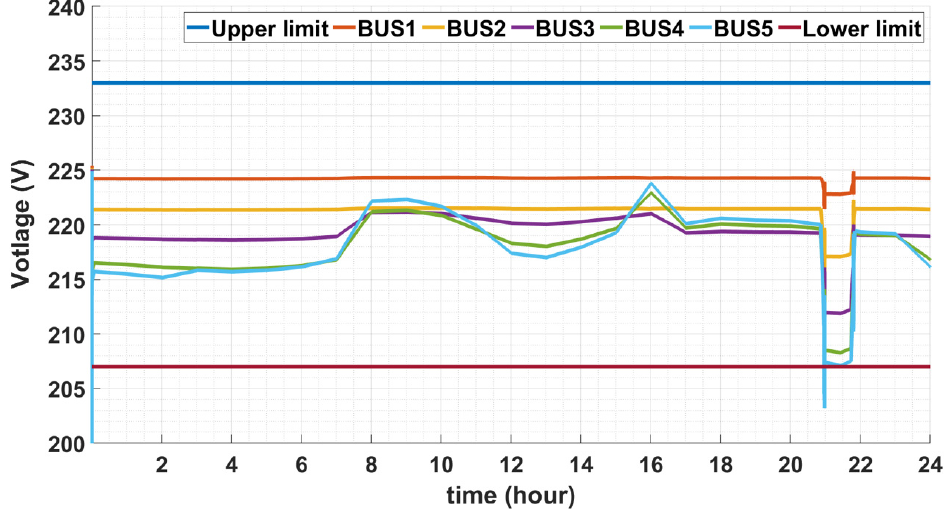
Figure 13. Bus voltage of the stand-alone MG.